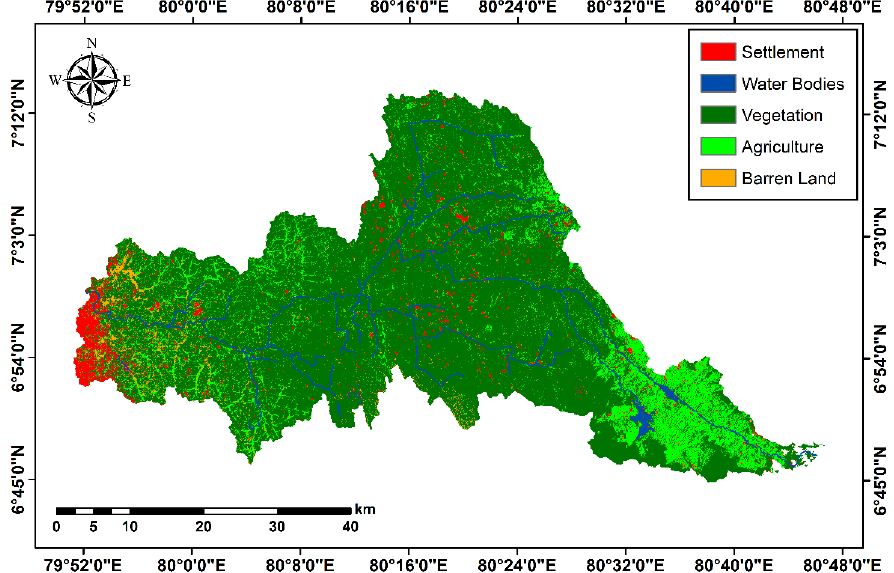
Figure 4. Land-use land-cover maps of Kelani River Basin in 1997. Table 3. Land-use classes in Kelani River Basin (in 1997) and corresponding SWAT codes.